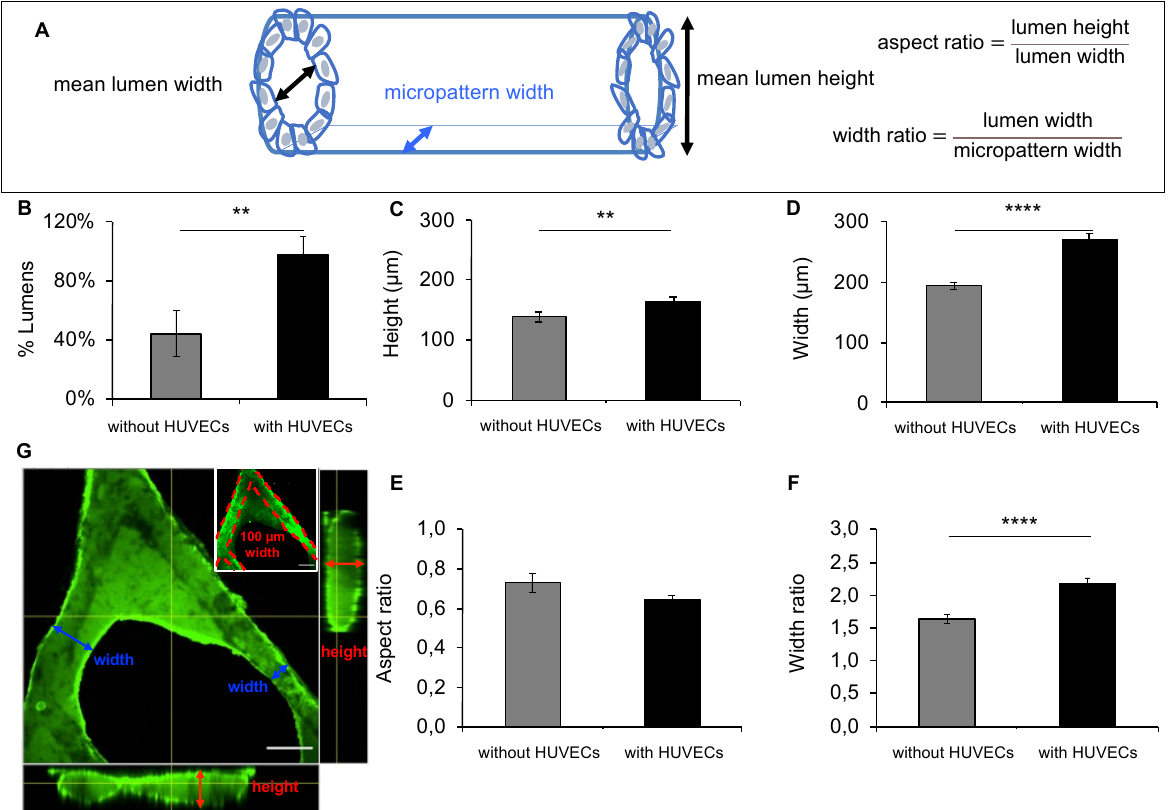
Figure 3. Impact of culture conditions on tubular geometry and frequency of lumen formation. ( A ) scheme depicting tube height and width, micropattern width, and aspect and width ratios formulas. Analysis of confocal pictures of fluorescein- stained day 10 tubular networks post-HUVEC seeding (with HUVECs, black bars) or NRC seeding (without HUVECs, gray bars) in the co-culture medium on 100 µm and 150 µm micropattern branches, n = 5 independent experiments and 65 and 34 confocal stacks were analyzed to calculate the mean in the presence or absence of HUVECs, respectively, ( B ) percentage of lumens ± SEM, ( C ) height ± SEM, ( D ) width ± SEM, ( E ) aspect ratio ± SEM, and ( F ) width ratio ± SEM, and ( G ) transversal projection (XY plane) of a biliary network structure secreting fluorescein into its lumen imaged in confocal and